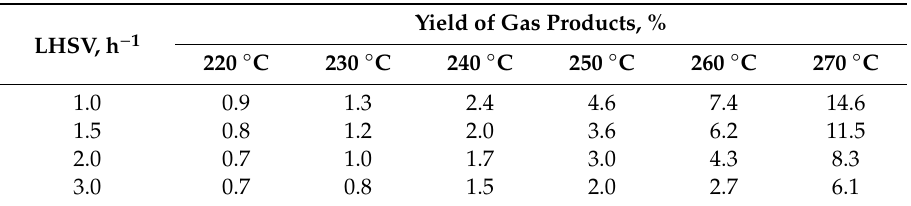
Table 5. Yield of the gas products as a function of process parameters (catalyst: Pt / H-Mordenite / Al 2 O 3 , feedstock: “B”).